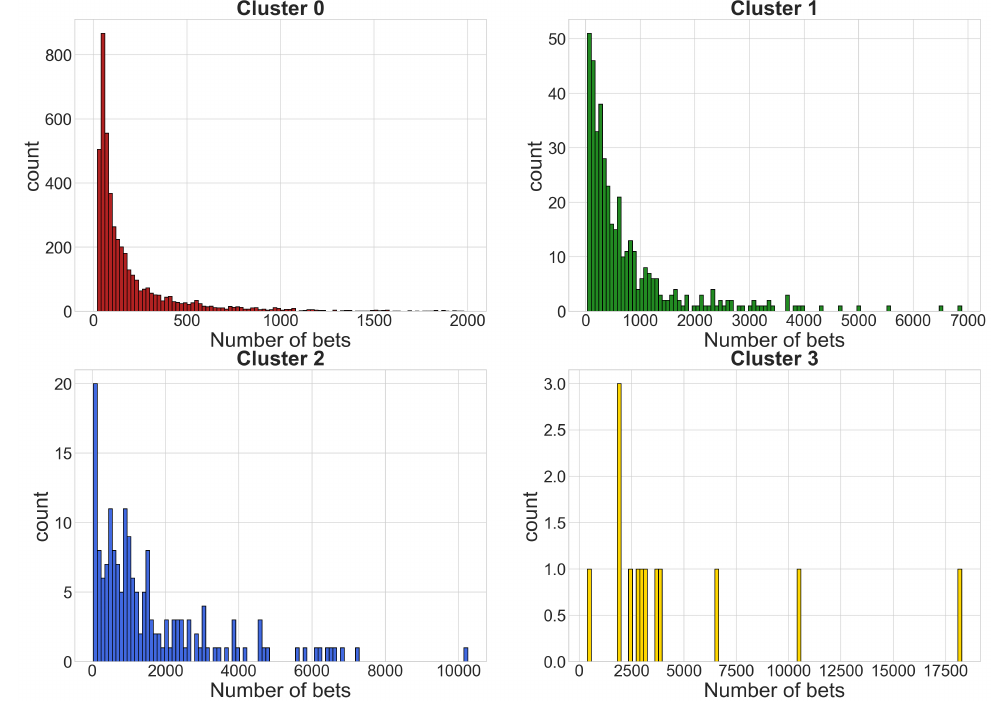
Figure 15. Histograms of the number of bets obtained using the time series k -means algorithm. The x axis reports the number of bets, while the y axis shows the number of players that have performed that amount of bets during the month.